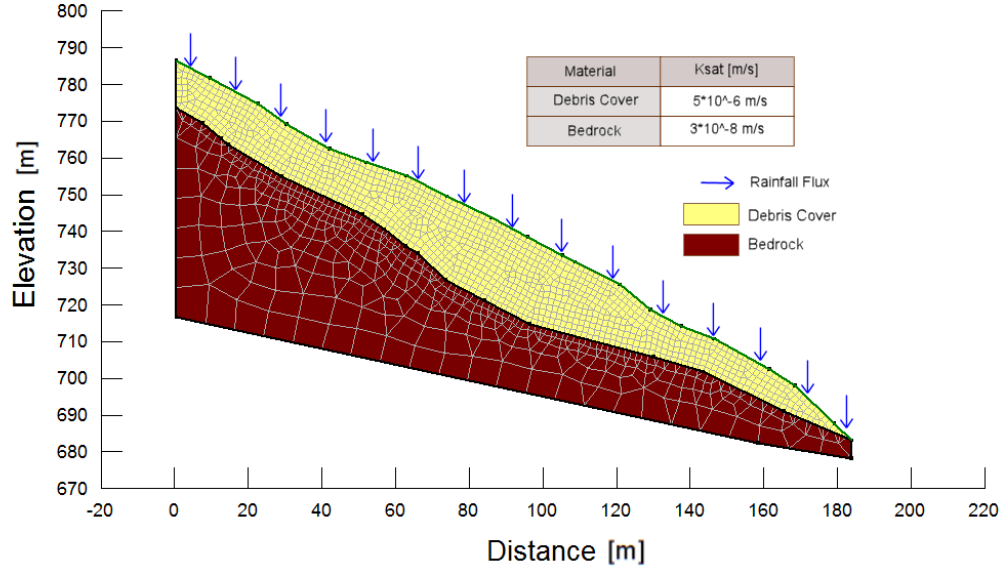
Fig. 12. Simplified model used to perform slope stability analysis in seepage conditions due to rainfall depths with different return